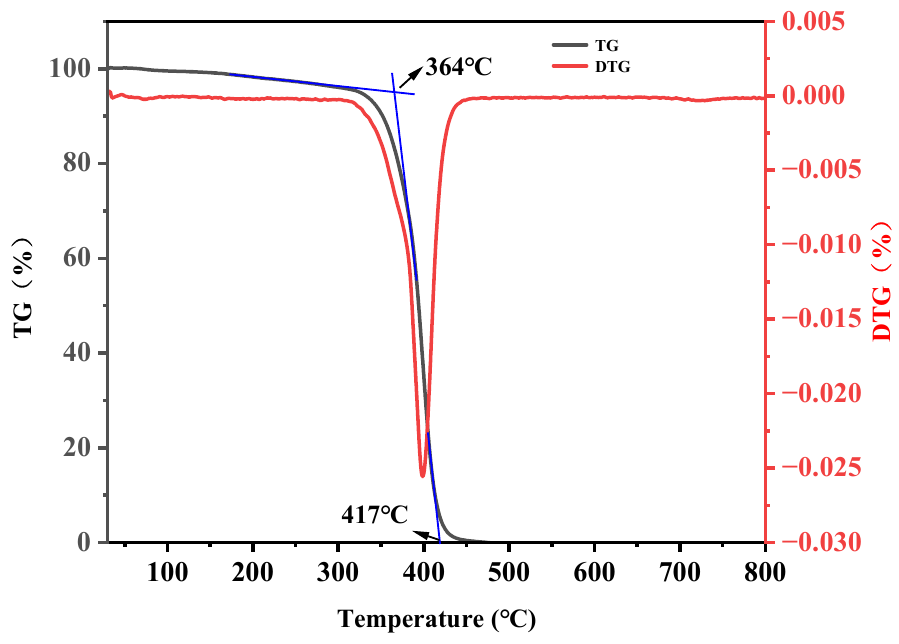
Figure 3. Poly (MMA-BA-ST) thermogravimetric analysis chart.